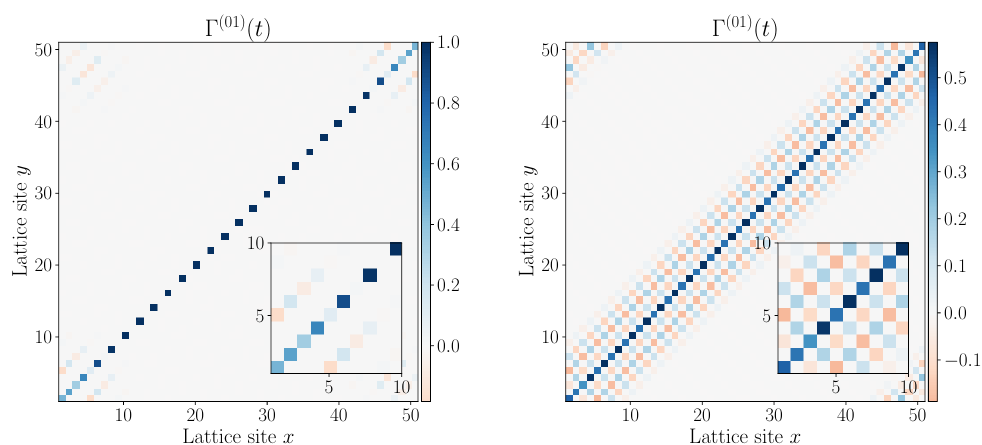
Figure 2: Covariance matrix of a charge-density wave Γ ( 0,1 ) which corresponds to the Fock state vector | 0,1,0,1,... 〉 has varying equilibration behaviour depending on the locality of the Hamiltonian and the system size parity. For the next-nearest- neighbour model the system in this special initial state splits up into two independent sub-lattices and is in an exact steady state whenever the system size L is even. How- ever, for odd L the symmetry of the density distribution is incommensurate with the system size and there is necessarily a defect of the type | ...,0,1,0,0,1,... 〉 or | ...,1,0,1,1,0,1,... 〉 around which the charge-density wave pattern starts becom- ing homogeneous. Note, that away from the defect point the charge-density wave looks locally like a steady state of the Hamiltonian and one can prove by the LR bounds that the middle region will remain unaffected for extensively long times. The left plot shows Γ ( 0,1 ) ( t = 1.5 ) after a quench to the next-nearest-neighbour model (the inset throughout shows the sub-block of the first 10 sites). On the other hand, if we quench to the nearest-neighbour model then there is no transient symmetry present and the charge-density wave is completely non-resilient and homogeneously tends towards equilibrium as seen in the right plot for the same initial